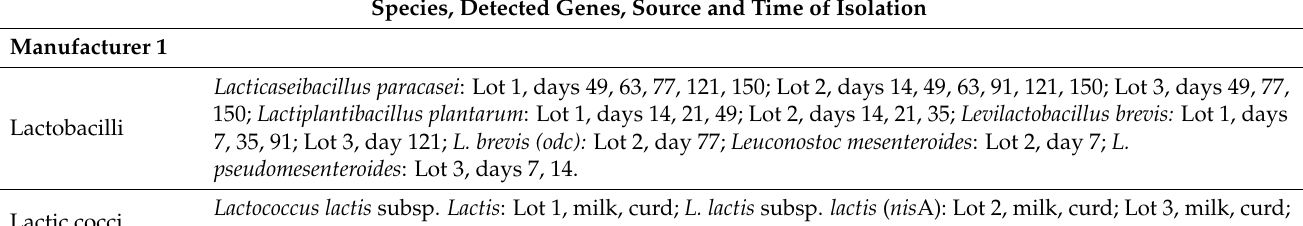
Table 1. LAB isolates with detected genes per manufacturer, production lot and time of isolation. Species, Detected Genes, Source and Time of